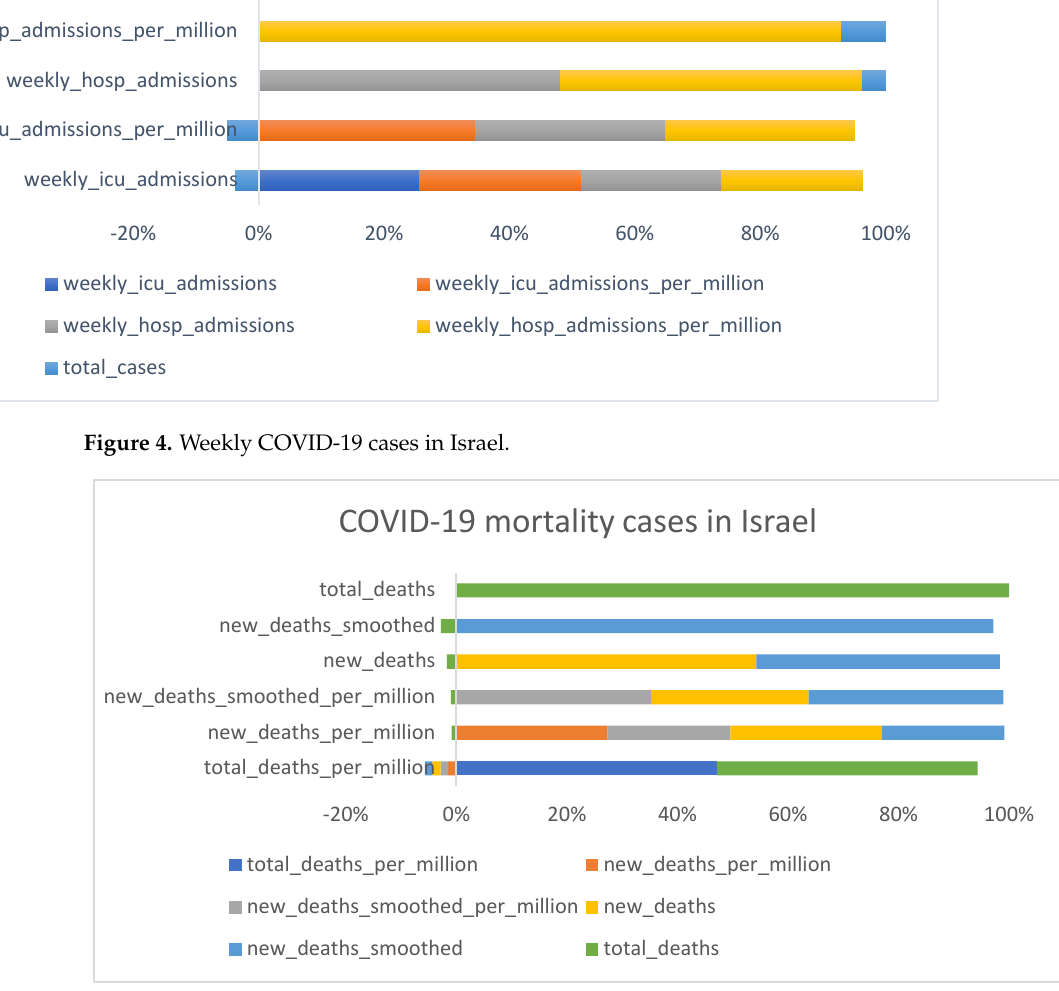
Figure 5. COVID-19 mortality cases in